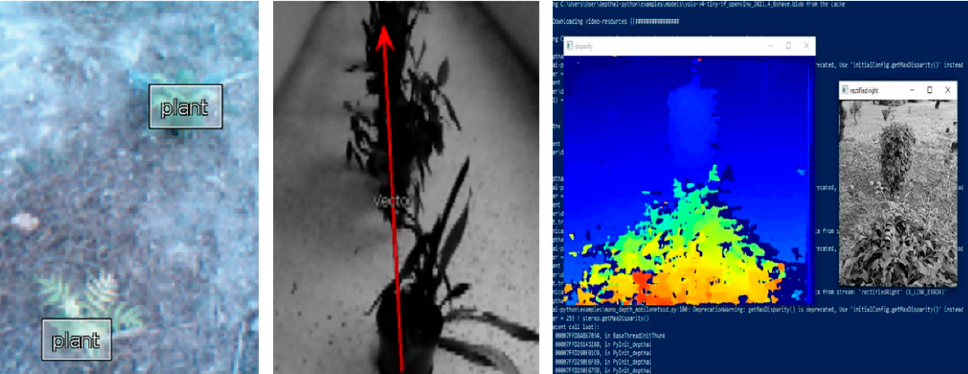
Figure 10. Indicative machine vision module capabilities: plants identification (Pixy2), vector extraction (Pixy2), and depth map extraction (Luxonis OAK-D).